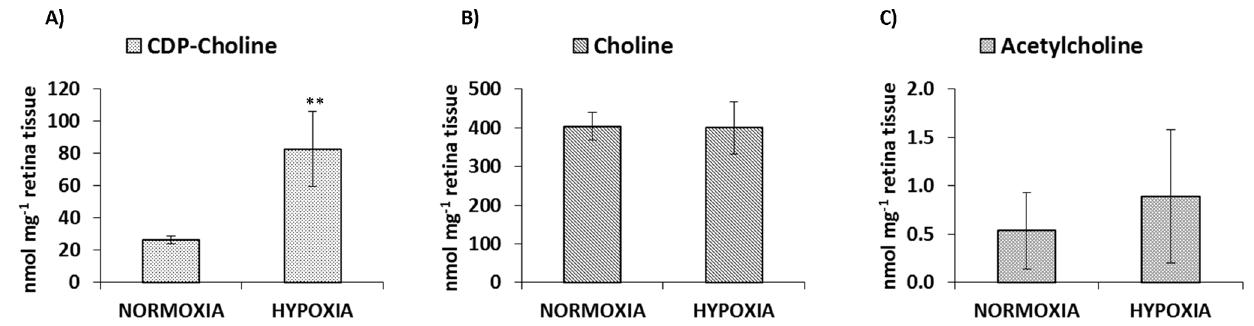
Figure 4. Concentrations of choline, acetylcholine and CDP-choline found by target analysis. Mean concentrations of CDP-choline (A) choline (B), acetylcholine (C) and (expressed as nmol/mg of tissue) in retina samples as determined by UPLC-triple quadrupole